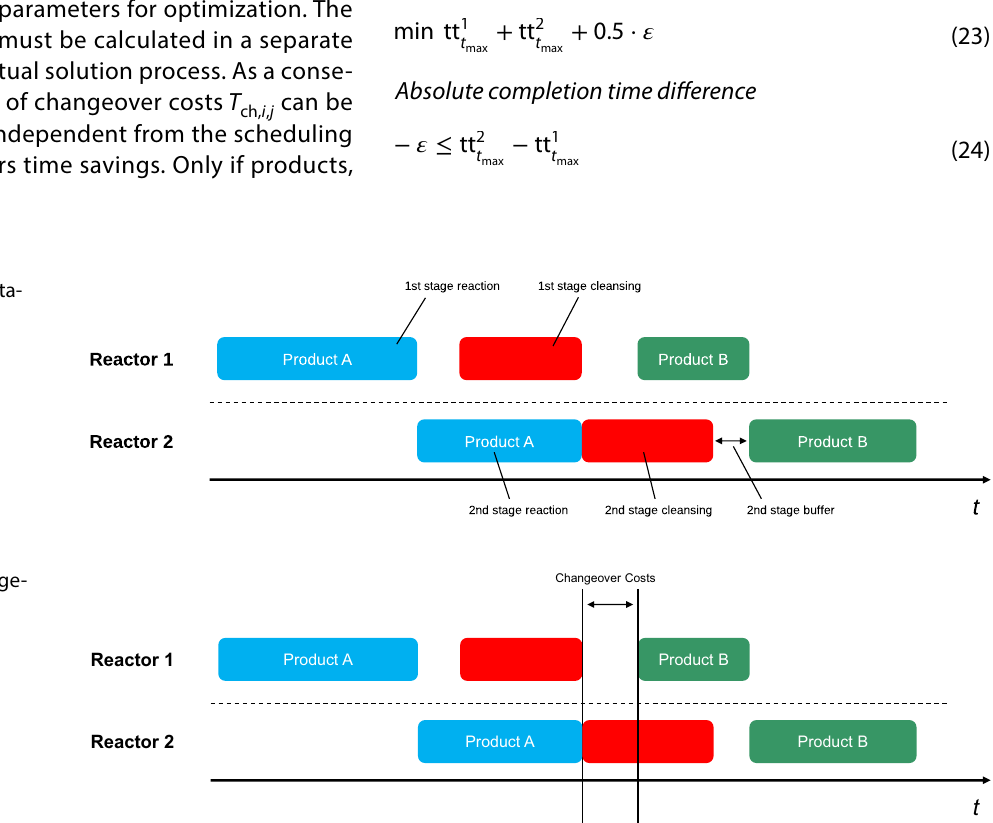
Fig. 3 Visualization of change- over